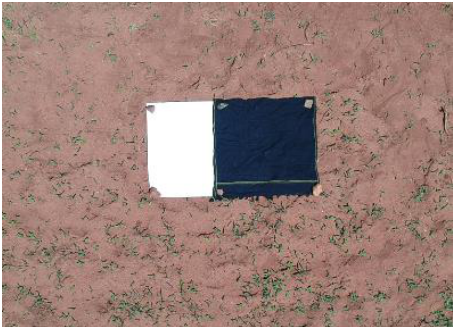
Figure 3 . Black and white reference panels placed in the field prior to the flight mission.